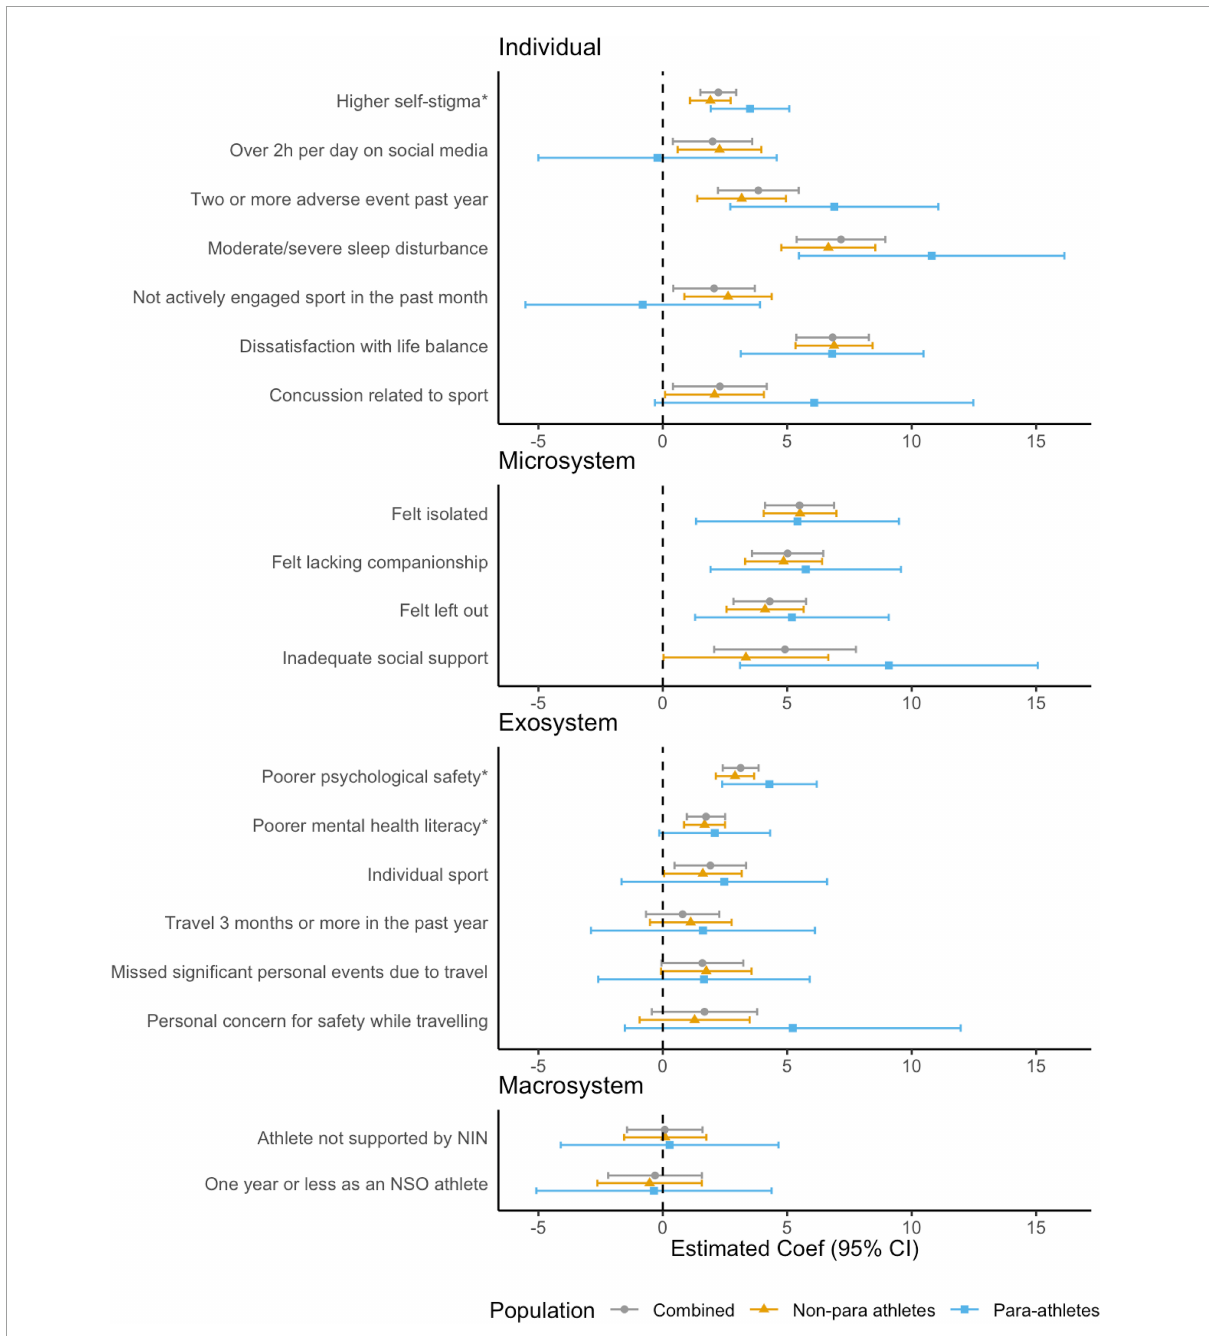
FIGURE2 Associations between risk factors and general psychological distress (K-10) for combined, non-para and para athletes, adjusted for age and gender. *Effects associated with one standard deviation ( SD ) change in Psychological Safety subscales (Low Self-Stigma, Mentally Healthy Environment, and Mental Health